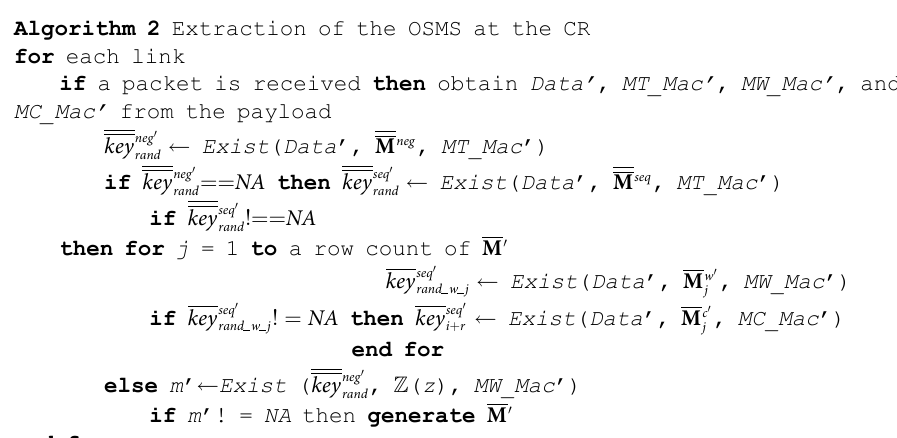
Algorithm 2 Extraction of the OSMS at the